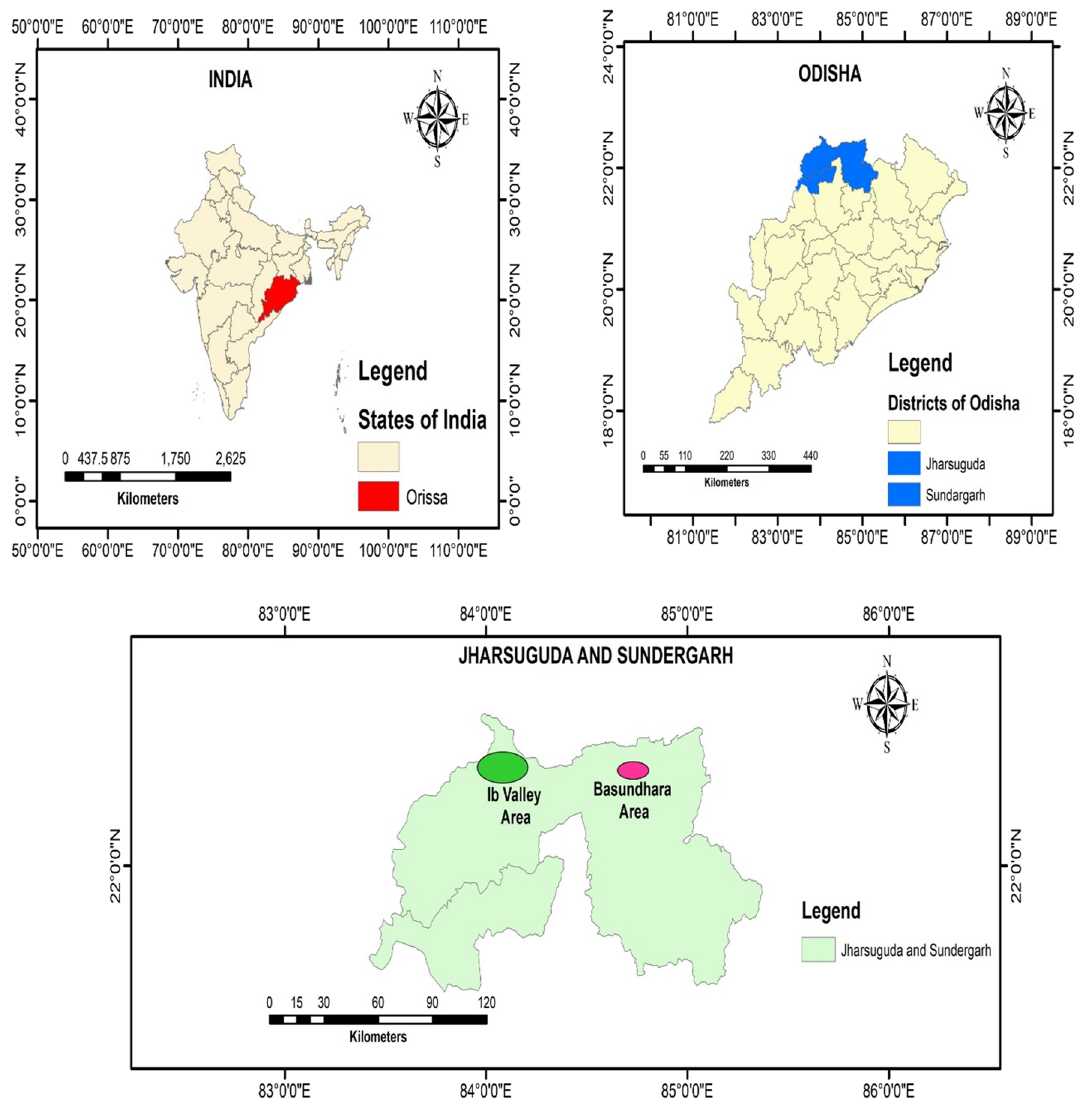
Fig. 1 Location Map showing India, Odisha, Jharsuguda, Sundergarh, Ib Valley area and Basundhara